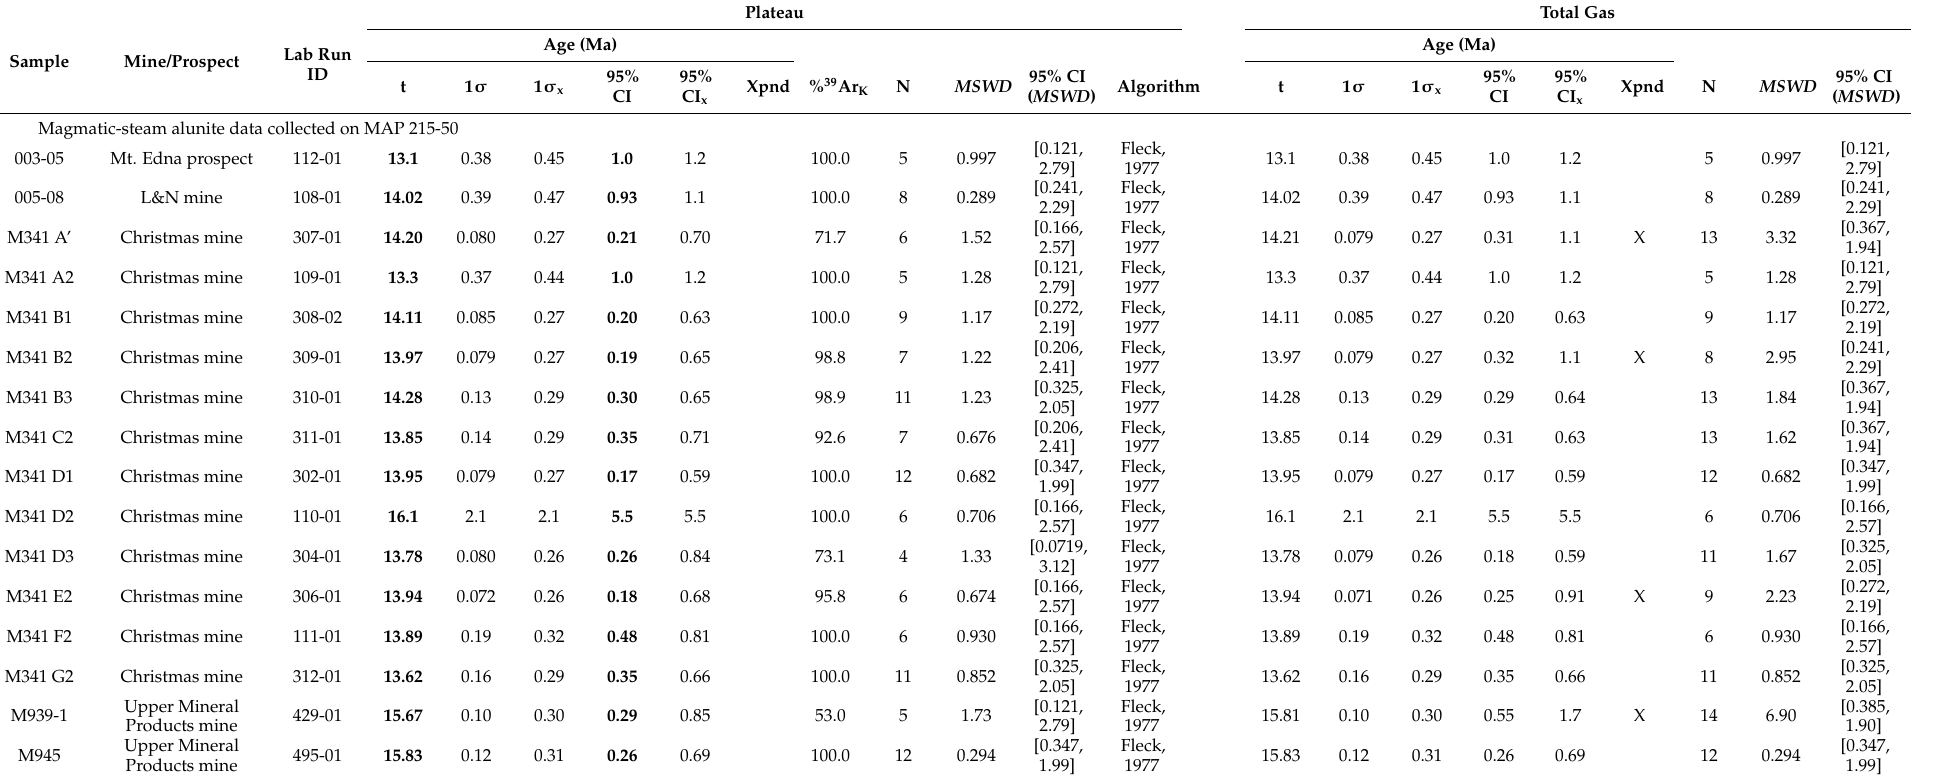
Table 1. Summary of plateau and total gas 40 Ar/ 39 Ar dates for samples of magmatic-steam alunite from Alunite Ridge, and sericite from the Deer Trail mine workings, Marysvale, Utah. Preferred ages are in bold. Age uncertainties are provided at both the 1 σ and 95% confidence (95% CI) lev- els, and include the error in J; external uncertainties (denoted by a subscript x) also include decay constant uncertainties. Dates have been rounded to the same decimal place as the 95% CI (internal) uncertainties, which are rounded to 2 significant figures. Acceptable MSWD values fall within the 95% confidence intervals computed following the methods of Mahon, 1996 [40]. Where the MSWD values are unacceptable, the 95% CIs (inter- √ MSWD and are denoted with an X in the Xpnd column; the 1 σ uncertainties are provided nal and external) of the ages have been expanded by without